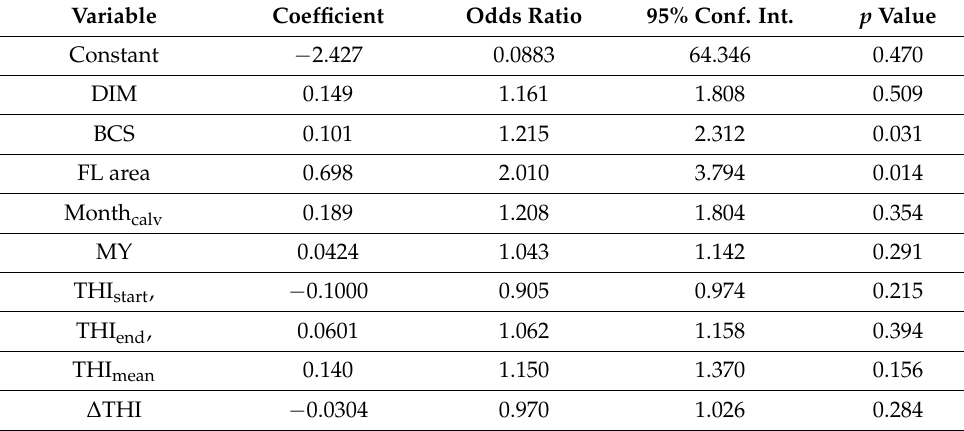
Table 4. Results (odds ratios and 95% confidence intervals) of the logistic regression analysis for the risk of pregnancy at timed artificial insemination (TAI), considering several factors: days in milk (DIM); body condition score (BCS); area of the preovulatory follicle (FL area); month of calving (month calv ); milk yield (MY); and the THI recorded at the start (THI start ), at the end (THI end ), and during (THI mean ) the trial. Data on THI excursion during the synchronization period were also considered ( ∆ THI). Variable Coefficient Odds Ratio 95% Conf. Int. p Value Constant − 2.427 0.0883 64.346 0.470 DIM 0.149